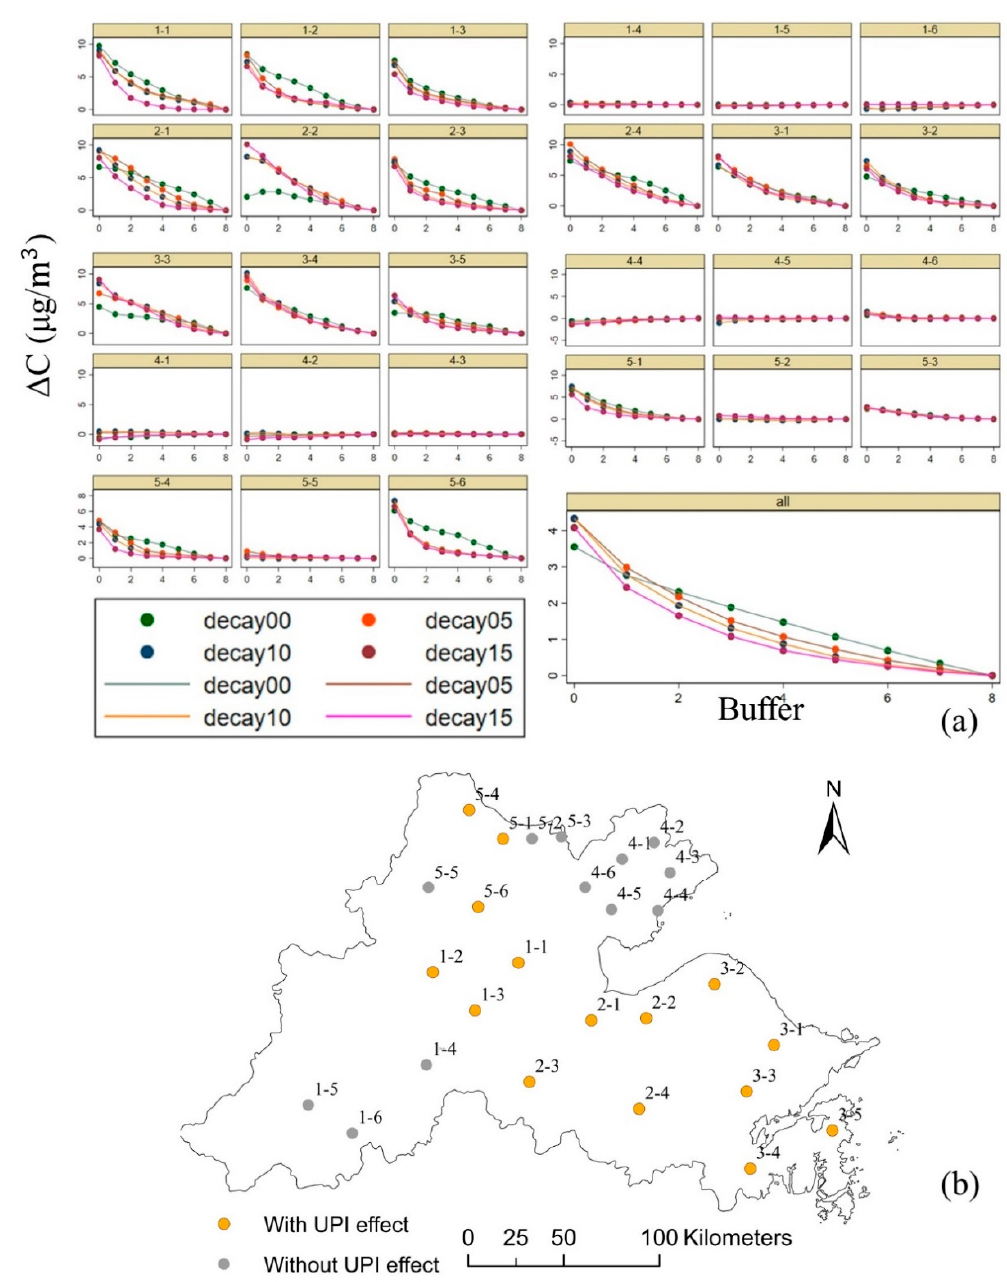
Figure 7. The occurrence of the UPI effect. ( a ) Trends of concentration difference ( Δ C) from the urban area to the buffer zones for the 27 urban areas in the Hangzhou Bay area in 2000, 2005, 2010, and 2015; ( b ) spatial distribution of the urban areas with the UPI effect.